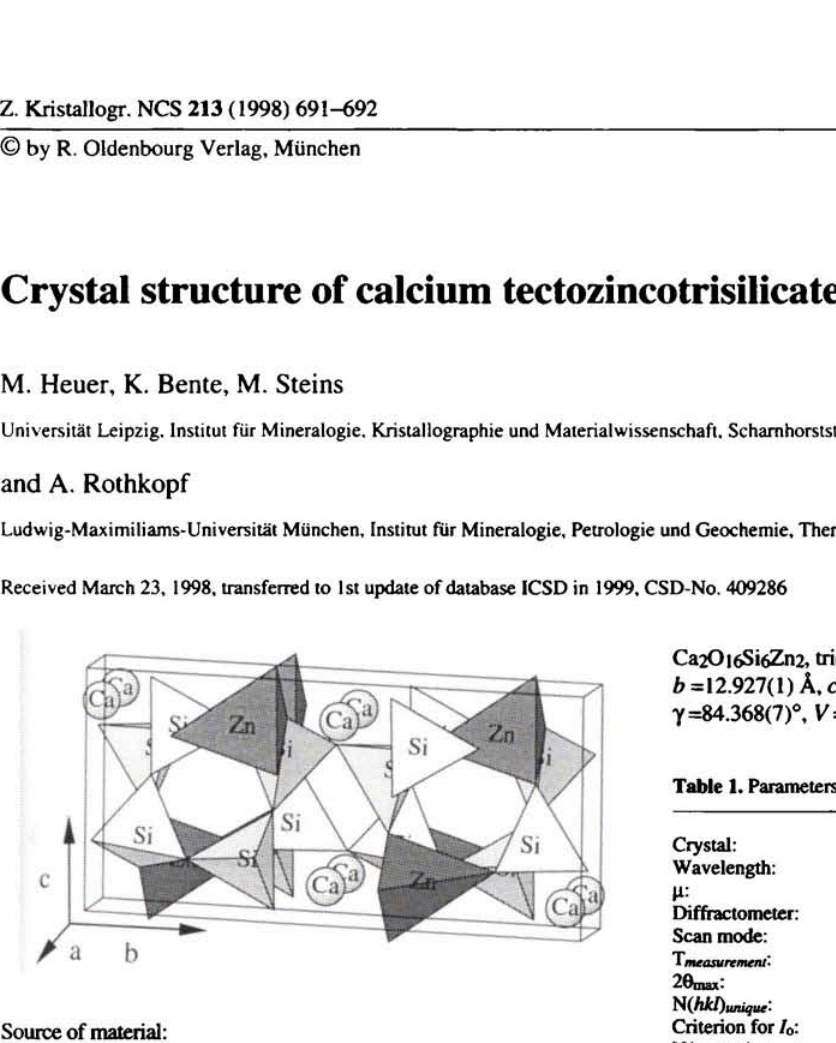
Table 1. Parameters used for the X-ray data collection